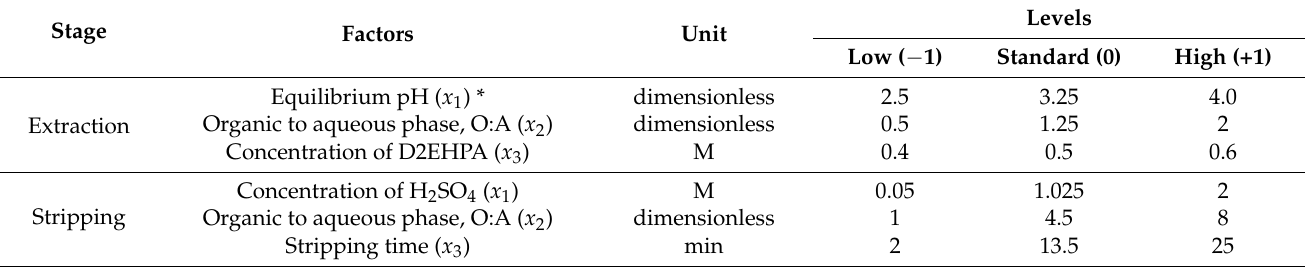
Table 2. Factors considered in the factorial design of experiments of the extraction and stripping stages and respective levels. Stage